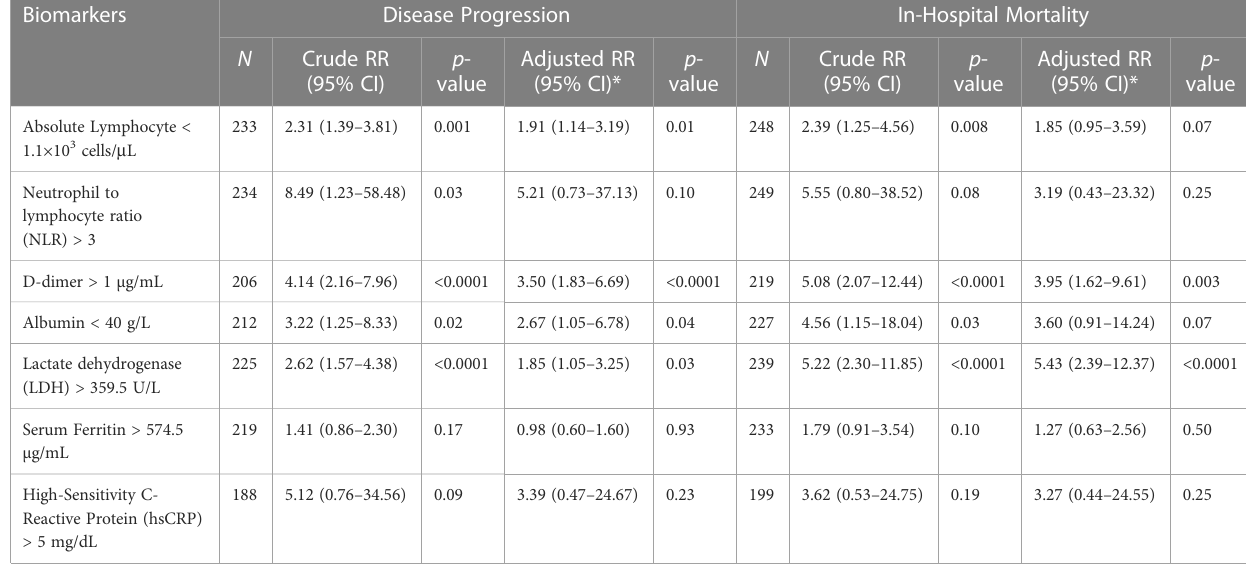
TABLE 2 Association of Selected Biomarkers (taken on Days 4-10) with Disease Progression and In-Hospital Mortality.